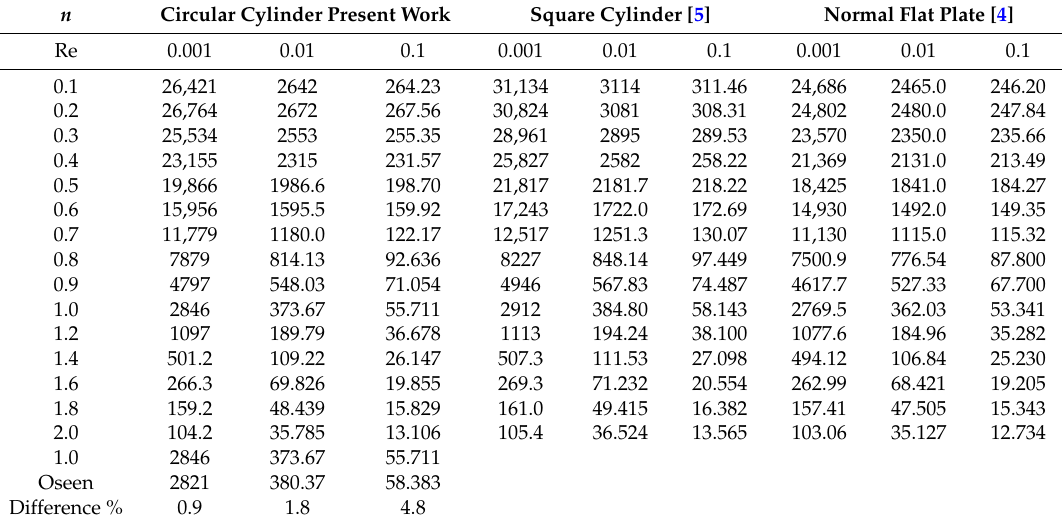
Table 1. Values of the drag coefficient for flow normal to a circular cylinder, square cylinder and flat plate at low Reynolds numbers.